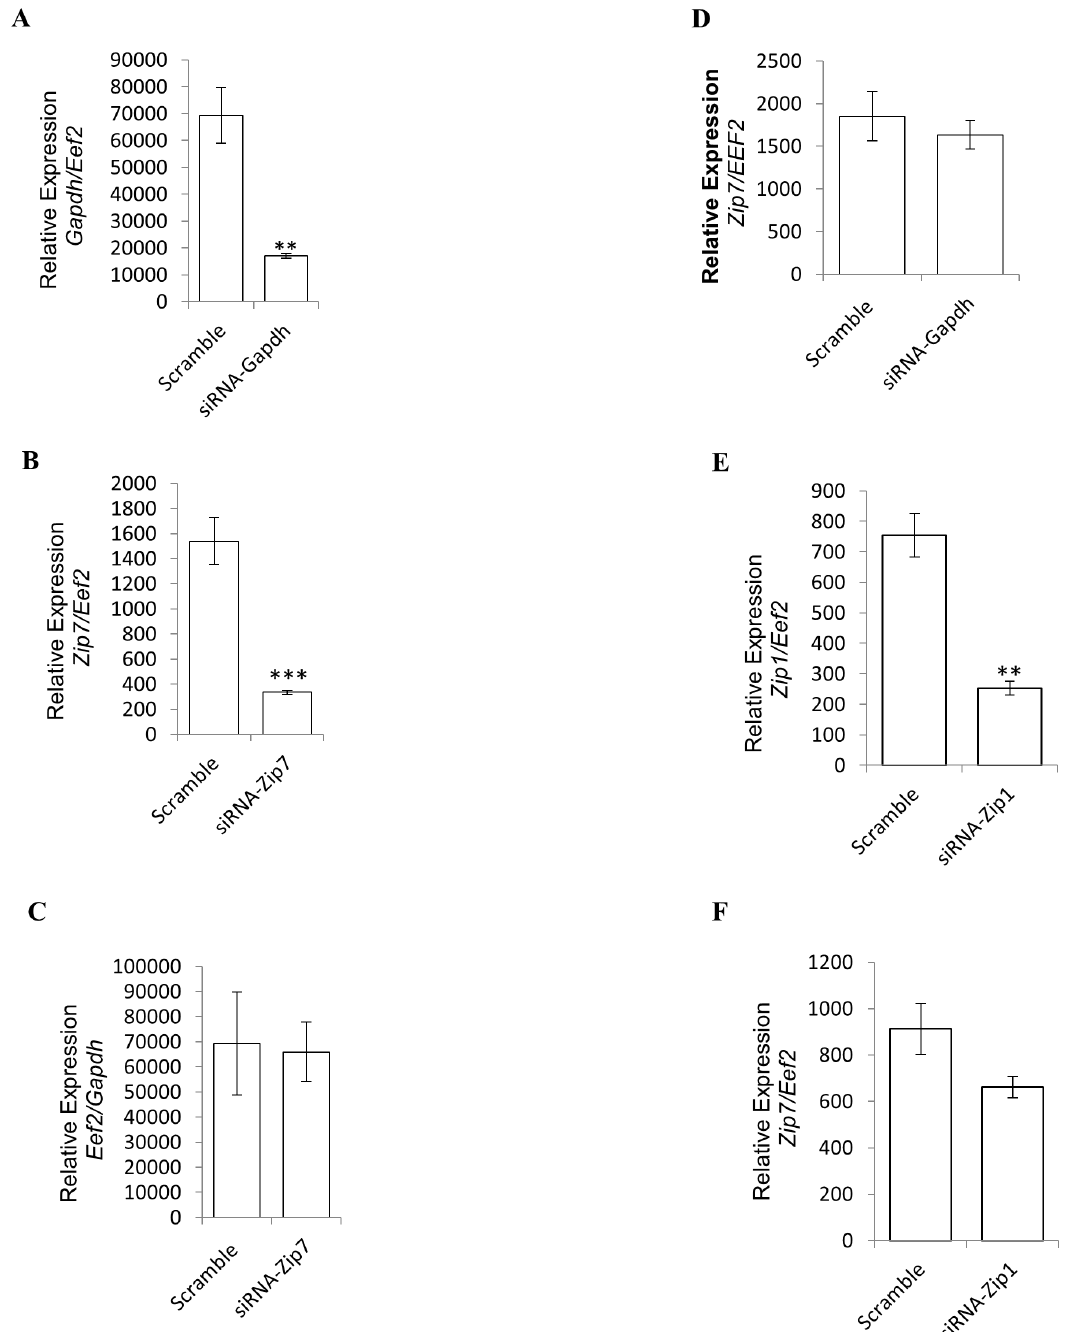
Figure 3. Zip7 mRNA is attenuated by si-RNA-Zip7. Relative expression of Gapdh, Zip7, Zip1 and Eef2 in the scramble control and corresponding siRNA cells, respectively. A). Gapdh relative to Eef2 in siRNA- Gapdh cells B). Zip7 relative to Eef2 in siRNA- Zip7 cells C). Eef2 relative to Gapdh in siRNA- Zip7 cells D). Zip7 relative to Eef2 in siRNA- Gapdh cells E). Zip1 relative to Eef2 in siRNA- Zip1 cells, and F). Zip7 relative to Eef2 in siRNA- Zip1 cells. Error bars indicated the 6 SD from three independent biological samples. ** P , 0.01, *** P , 0.001.